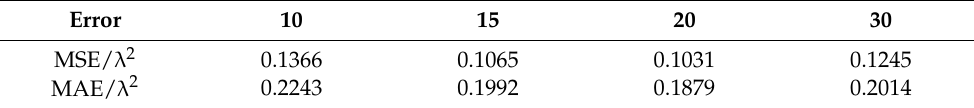
Table 4. Mean square error and mean absolute error of PV on different time steps.